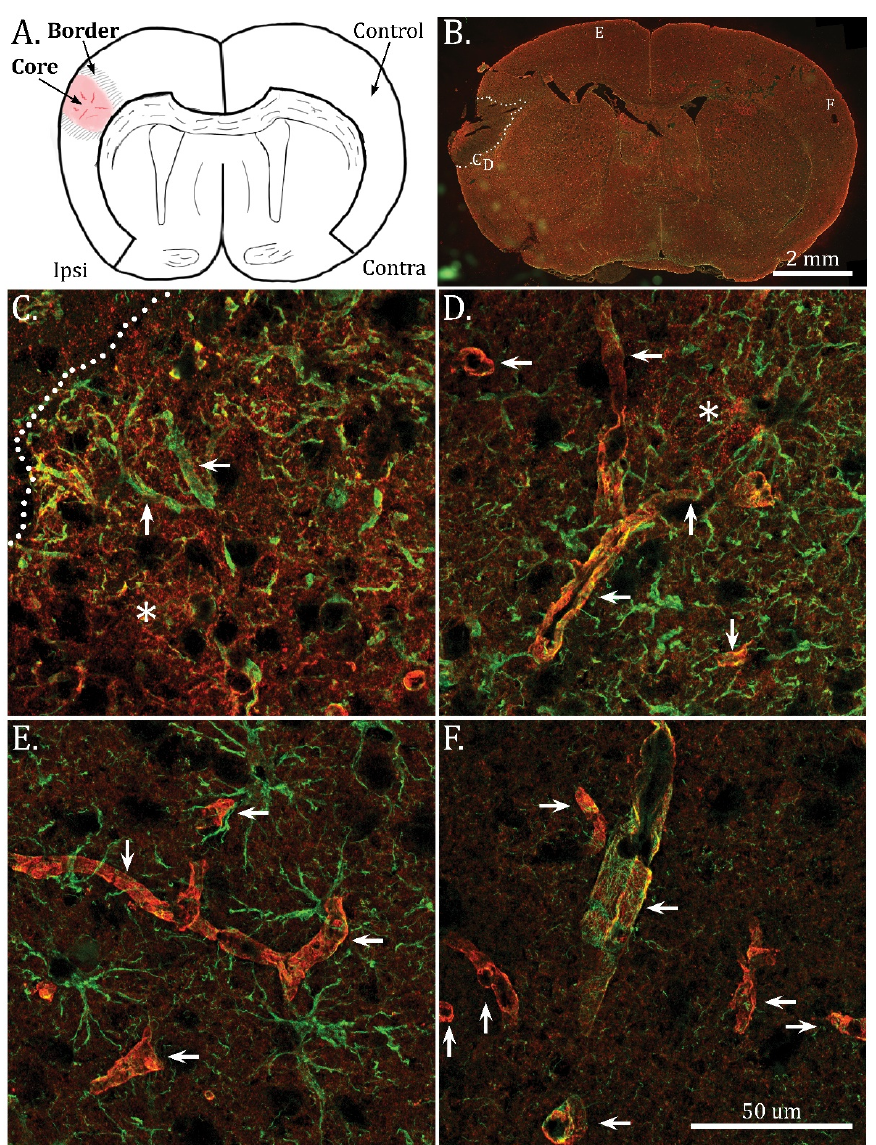
Figure 1. Immunofluorescence shows redistribution of AQP4 from perivascular to non-perivascular domains in the border zone of the infarct. ( A ) Illustration showing the infarct core in the cortex, ipsilateral to the dMCAO. ( B ) Scanned overview of a coronal section with AQP4 (red) and GFAP (green) immunofluorescence co-staining. Dotted lines show the limits of the infarct. Location of the high magnification images shown in ( C – F ) is indicated in the scanned overview. ( C – F ) Confocal z-projections (2 µ m thickness) of areas indicated in B, taken with a 63 × objective. Arrows indicate vessels, asterisk indicate strong AQP4 immunofluorescence staining in neuropil. ( C ) In the border zone closest to the infarct core, GFAP-positive astrocytic processes rectified towards the core (dotted line), are accompanied by diffuse AQP4 immunofluorescence staining throughout the area, with relatively modest immunostaining of the perivascular processes (arrows). ( D ) Moving further away from the core into the peri-infarct area, strong perivascular AQP4 staining (arrows) is accompanied by pronounced neuropil expression (asterisk). Strong GFAP immunofluorescence is present in astrocytic processes. ( E , F ). In the ipsilateral cortex remote from the infarct ( E ), and in the contralateral cortex ( F ), AQP4 immunofluorescence is mainly localized around the vessels (arrows). Strong GFAP staining, indicative of astrogliosis is more pronounced in the ipsilateral cortex. Pseudo-colors: red for AQP4 and green for GFAP. Scale Bars: ( A ); 2 mm, ( C – F ); 50 µ